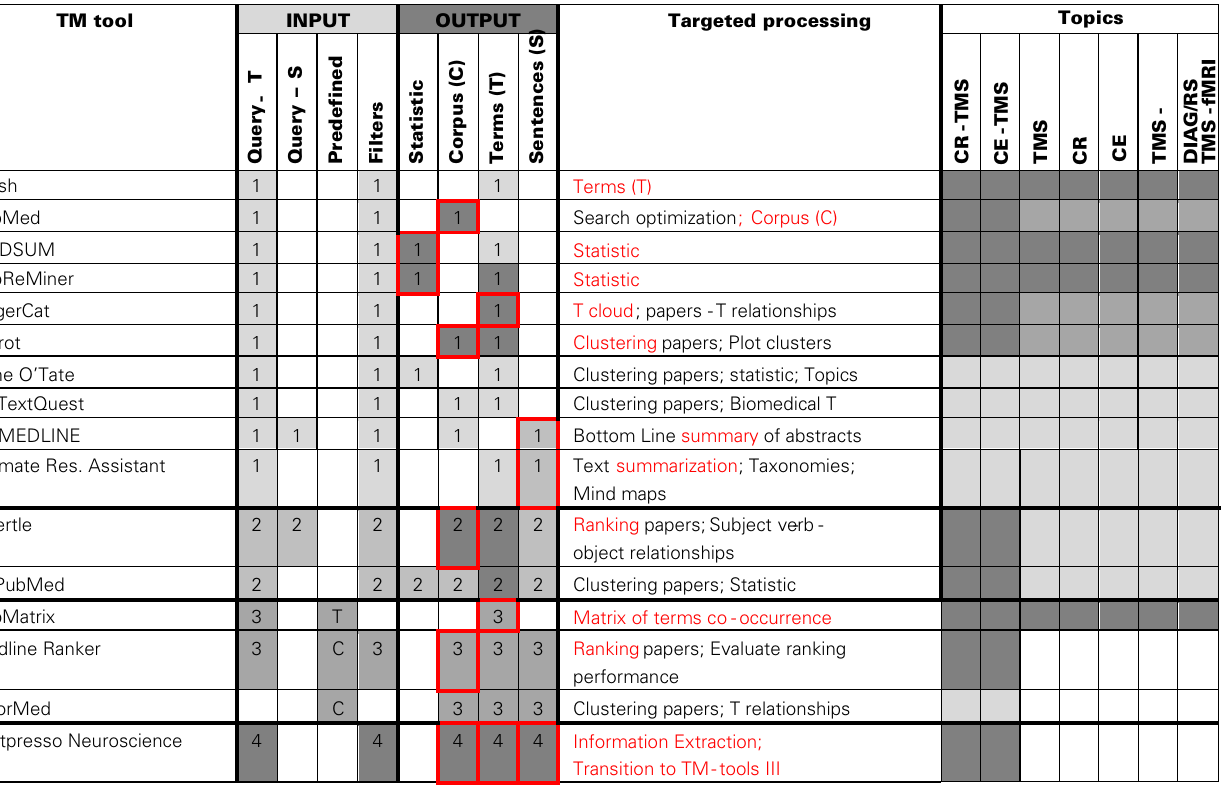
Table 1 | TM-tools II presented in the order (indicated by numbers) of their